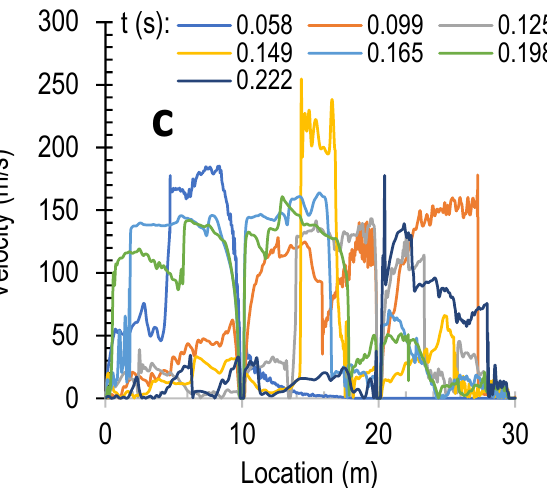
Figure 18. Local pressure ( a ), temperature ( b ), and velocity ( c ) monitored at different locations as a function of time in the scenario where Obstruction 1 and Obstruction 2 are half inflated and Obstruction 3 is fully inflated (with a 100% blockage).